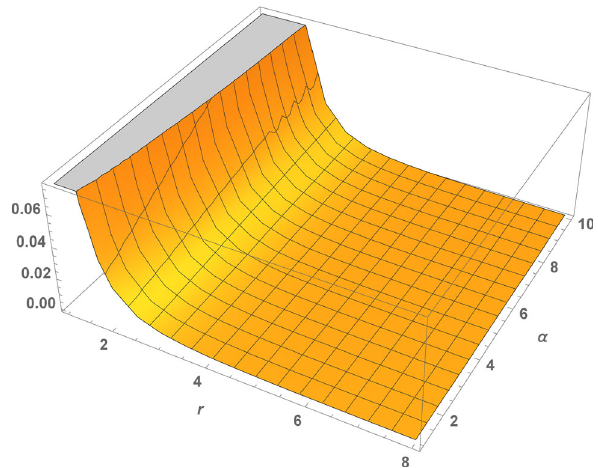
Fig. 2 Variation of energy density for λ = − 35 and different α